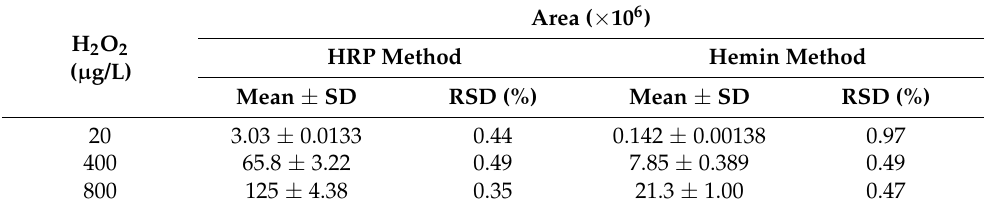
Table 5. Average value and RSD of six analysis results of H 2 O 2 standard solution with different concentrations.